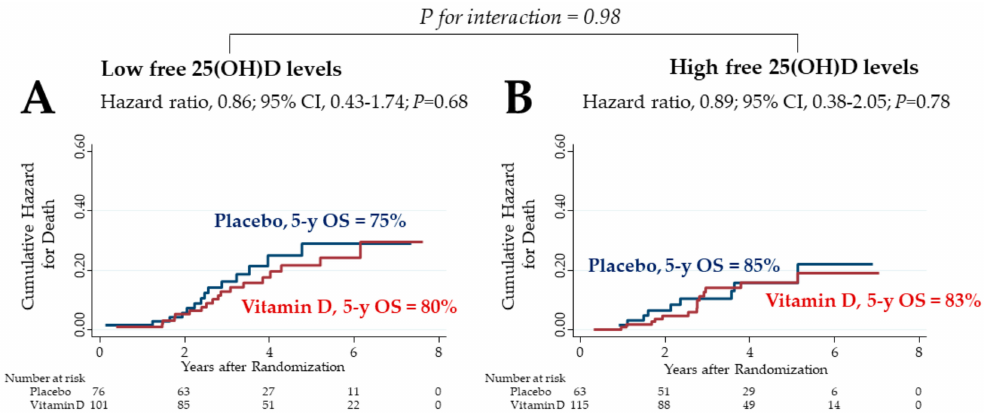
Figure 5. Nelson–Aalen cumulative hazard curves for death in the subgroups of free 25(OH)D levels lower ( A ) and higher ( B ) than median (5.70 pg / mL) before starting supplementation. 25(OH)D: 25-hydroxyvitamin D; CI: confidence interval; 5 y OS: 5 year overall survival.